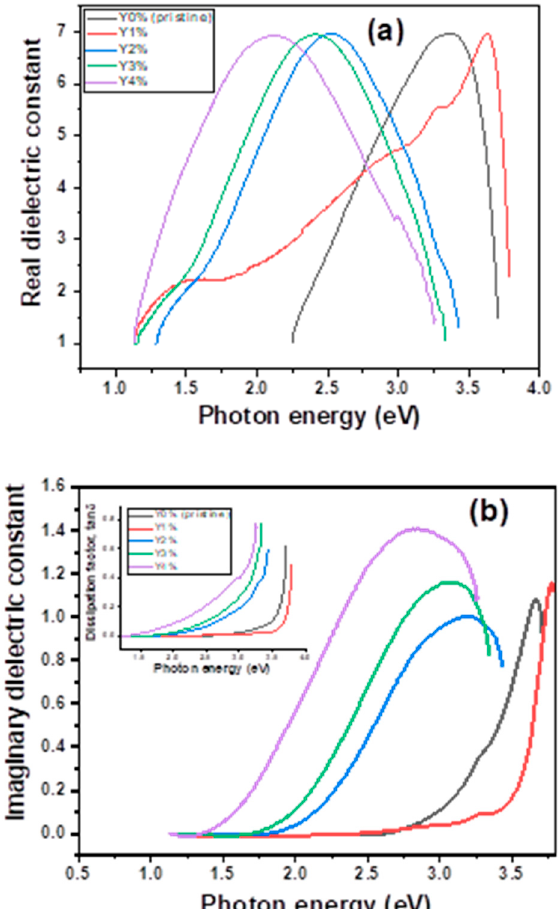
Figure 5. ( a ) Real dielectric ( b ) Imaginary dielectric plots of pristine and composite